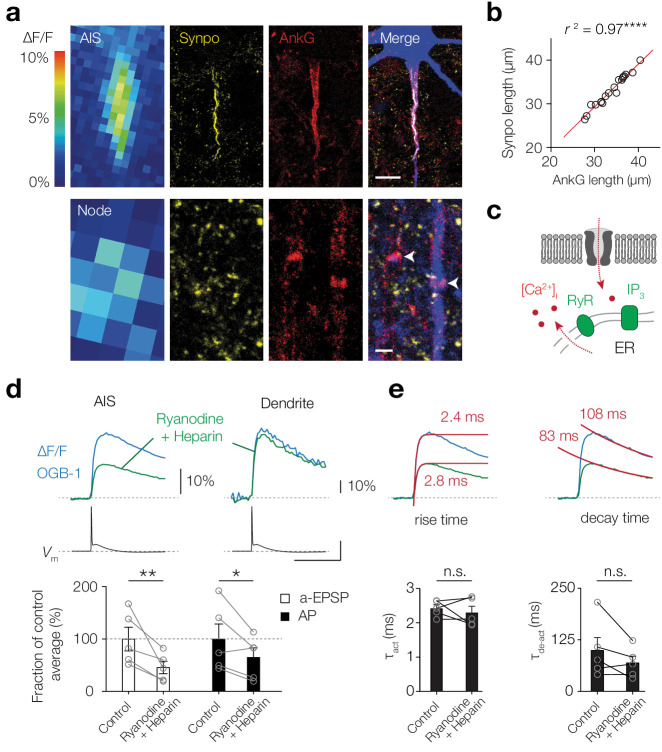
Giant saccular organelle amplifies activity-dependent Δ[Ca2+]i in the AIS.(a) Example color-coded maximal ∆F/F profile (100 μM OGB-1) in response to a-EPSPs in the AIS (top) and Node (bottom) compared to z-projections for synaptopodin (Synpo, yellow), Ankyrin-G (AnkG, red) and biocytin/streptavidin (blue) of the same axon. White arrows indicate the locations of nodes, in the imaged axon (blue) and a neighboring one, both without synaptopodin. The many small Synpo positive puncta are likely co-localized with subclasses of spines (Benedeczky et al., 1994; Bas Orth et al., 2007). Scale bars, 10 µm and 1 µm. (b) The length of synaptopodin fluorescence linearly scales with Ankyrin G length. Red trace, linear regression fit with y = 1.005 x – 0.95, r2 = 0.966, ****p<0.0001, n = 19. (c) Schematic of Ca2+-induced Ca2+ release by internal ER stores. (d) Top, example ∆F/F (OGB-1) transients from AIS (left) and dendrite (right) in response to an AP (Vm, black) in control conditions (blue) and re-patched with blockers (green). Scale bars, 10% ∆F/F, 50 mV and 50 ms. Bottom, population data of the peak ∆F/F in the AIS in response to a-EPSP (white bars) and AP (black bars) before and after store release block, one-tailed ratio paired t-tests, **p=0.0060, *p=0.021, n = 5. Open circles and connecting lines represent paired recordings from individual cells and bars show the population mean ± s.e.m. (e) Top, Ca2+ transients fitted with a single exponential function (red) to the rise (left) and decay time (right) in response to an AP, red number indicates the τ. Bottom, comparison of the rise and decay time (two-tailed paired t-tests, τact, p=0.52, τde-act, p=0.18, n = 5). Open circles and connecting lines represent paired recordings from individual cells and bars show the population mean ± s.e.m. Data available in Figure 2—source data 1.